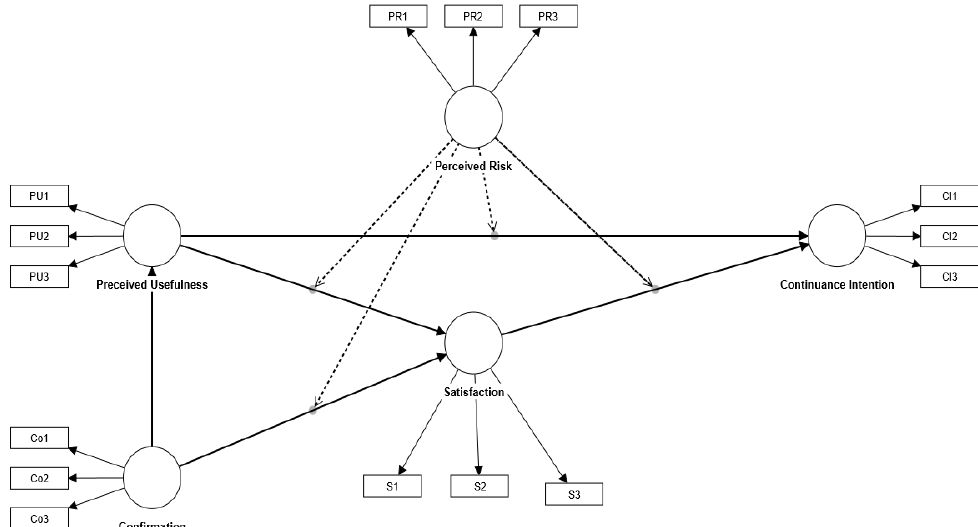
Figure 2. A framework for the moderating effect of perceived risk on Fintech via the Expectation Confirmation Model prism. Source: authors’ own work.